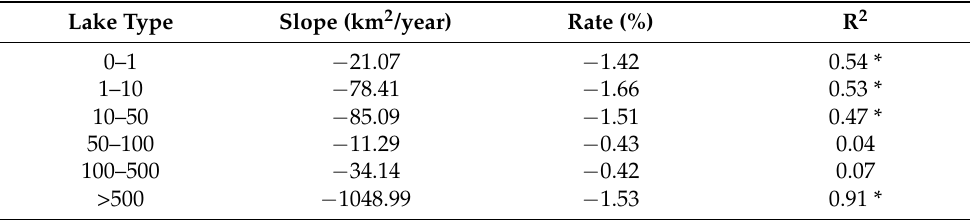
Table 4. The yearly area changes of lakes with different sizes .